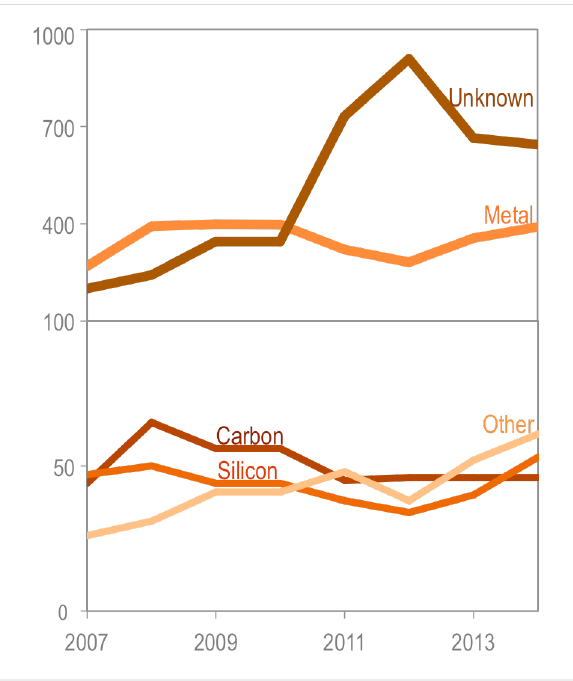
Figure 3: Major nanomaterial composition groups over time. Carbon = carbonaceous nanomaterials (carbon black, carbon nanotubes, fullerenes, graphene). Other = organics, ceramics, poly- mers, clays, nanocellulose, liposomes, nano micelles, carnauba wax, etc. Note the difference in scale between the top and bottom panels in this plot. tise to contain more than one main nanomaterial